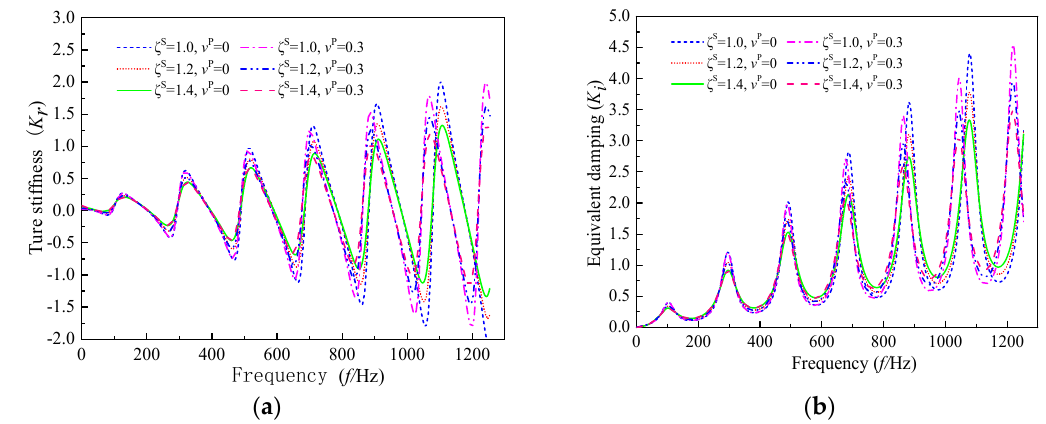
Figure 10. The effect of the degree soil is strengthened due to a construction disturbance on the longitudinal impedance of pile shaft: ( a ) true stiffness; ( b ) equivalent damping.